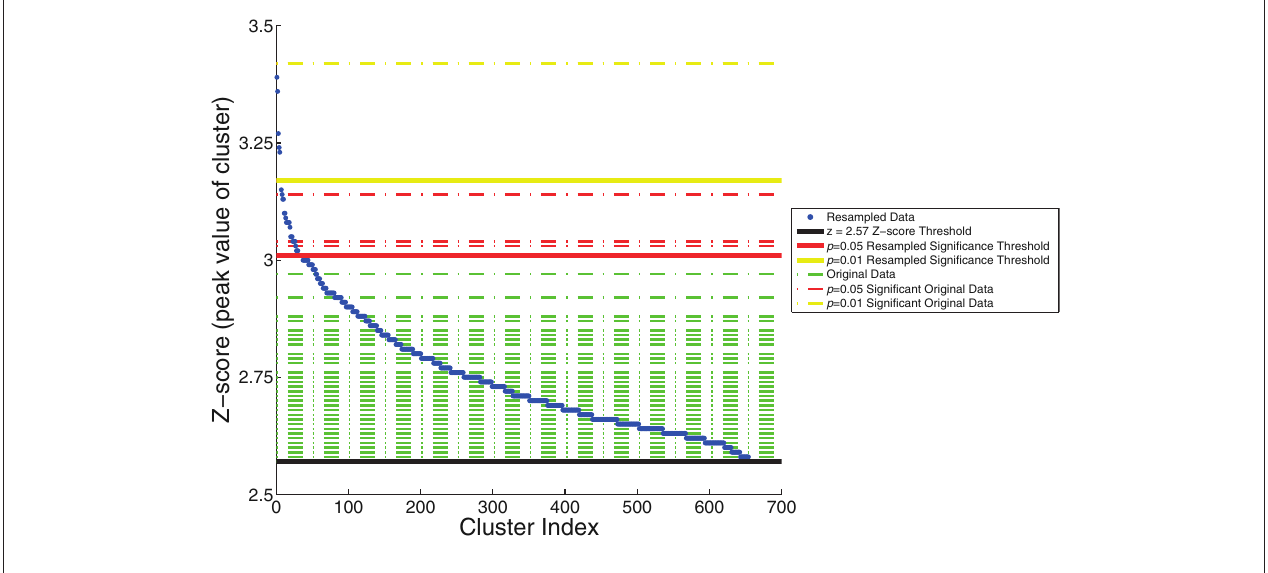
FIGuRE 4 | The resampling method, used to generate thresholds based on the maximum z -score within the cluster. The resampled data (in blue) are sorted and plotted in increasing z ‑score. Horizontal dashed lines of the z ‑scores of the original data are overlaid (in green). Three significance thresholds are shown: z = 2.57